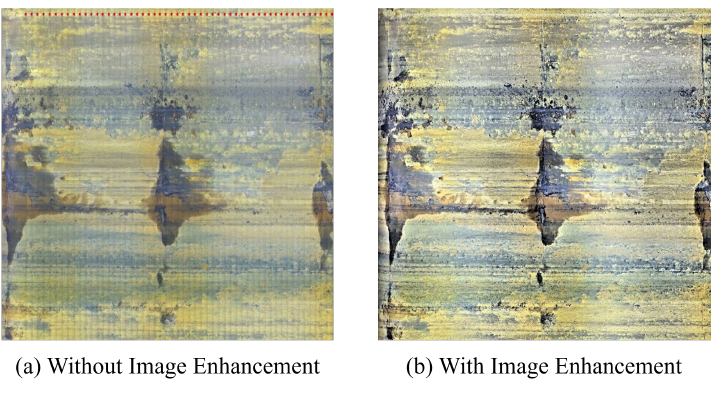
Figure 9. Image stitching